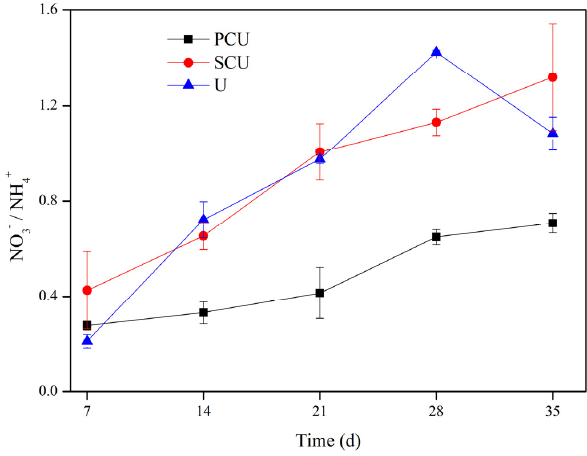
Figure 2. Dynamic changes of the NO 3 − /NH 4 +